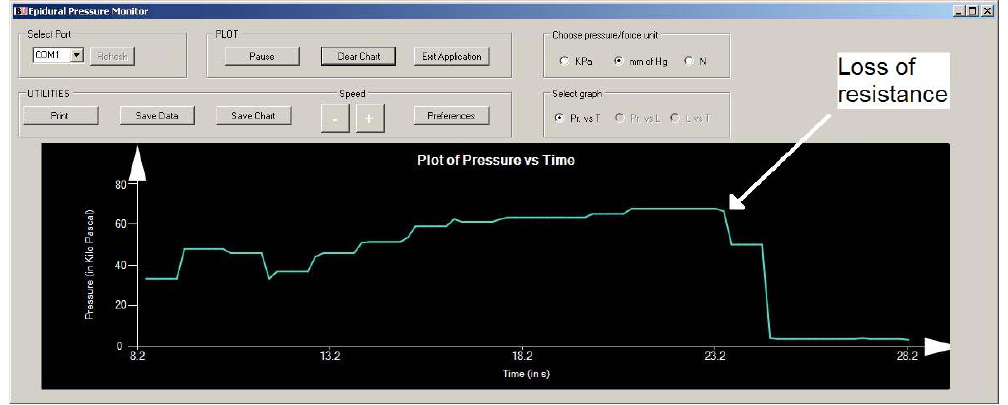
Figure 2. Software output clearly showing LOR.